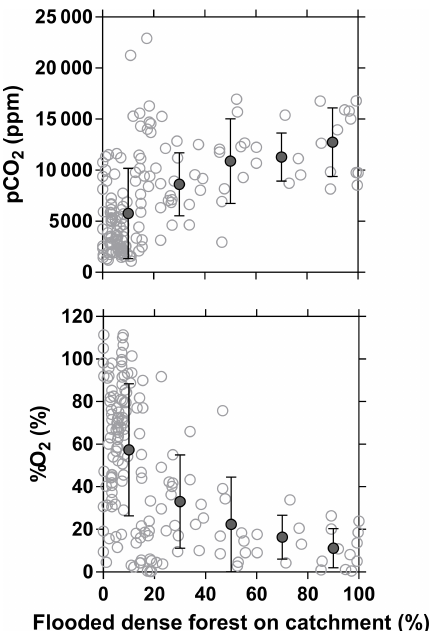
Figure 13. Partial pressure of CO 2 ( p CO 2 in ppm) and dissolved O 2 saturation level (%O 2 in %) in surface waters of rivers and streams of the Congo River network as a function of the flooded dense forest over the respective catchment (GLC, 2009). Grey open dots are individual data points, and black full dots are binned aver- ages ( ± standard deviation) by intervals of